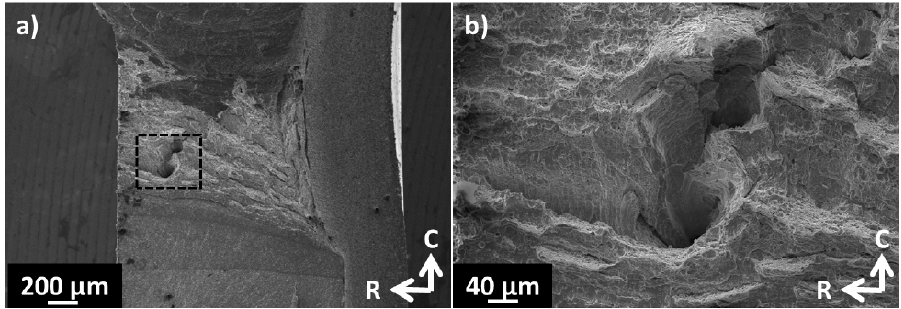
Figure 8. SEM image showing an arrested secondary crack in ( a ) low magnification and ( b ) high magnification in the L-C oriented specimen of ODS-KIT HE at RT.